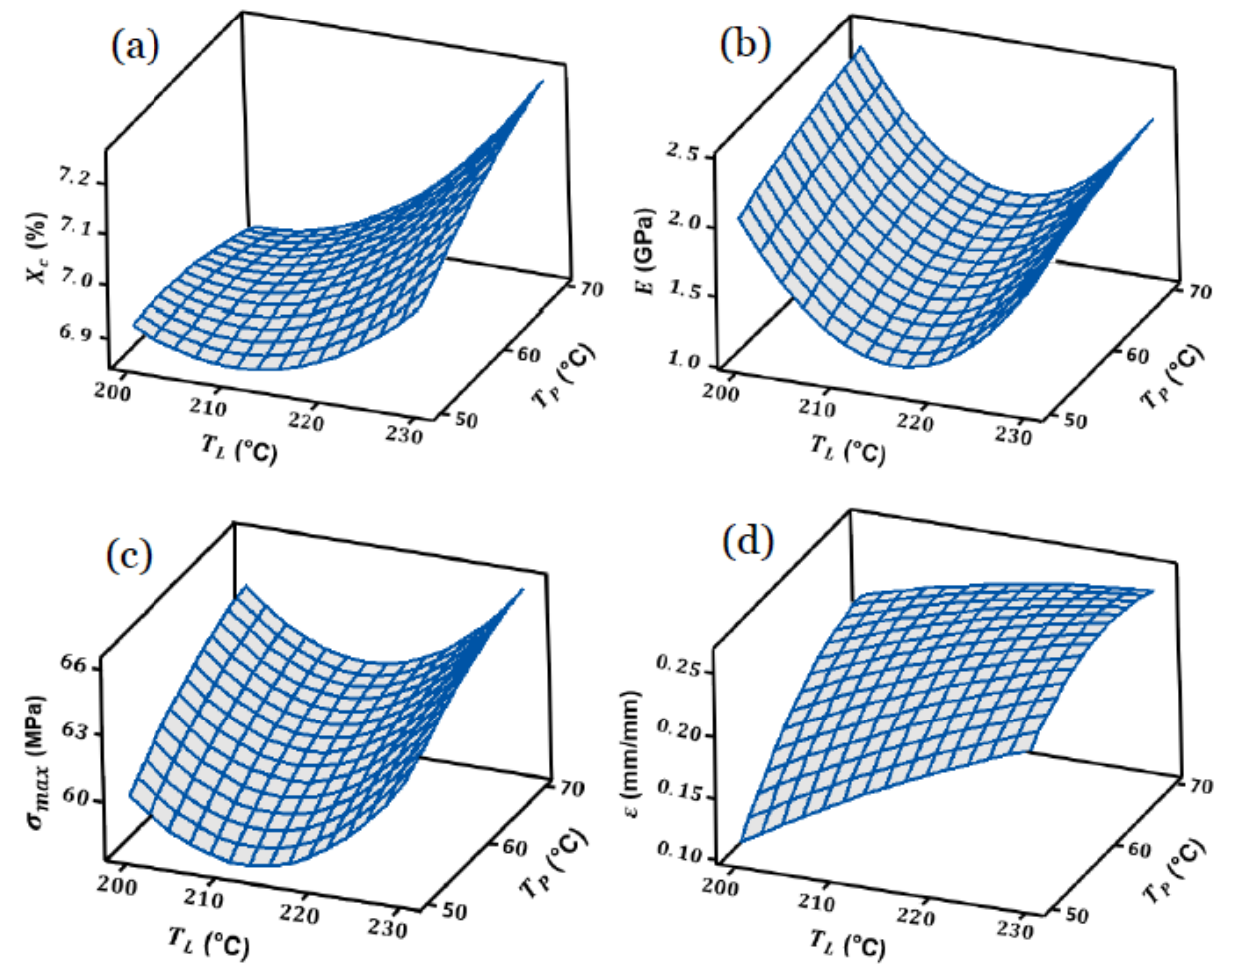
Figure 3. Response surfaces: ( a ) degree of crystallinity, ( b ) Young’s modulus, ( c ) tensile strength, and ( d ) elongation at break as a function of the process variables.